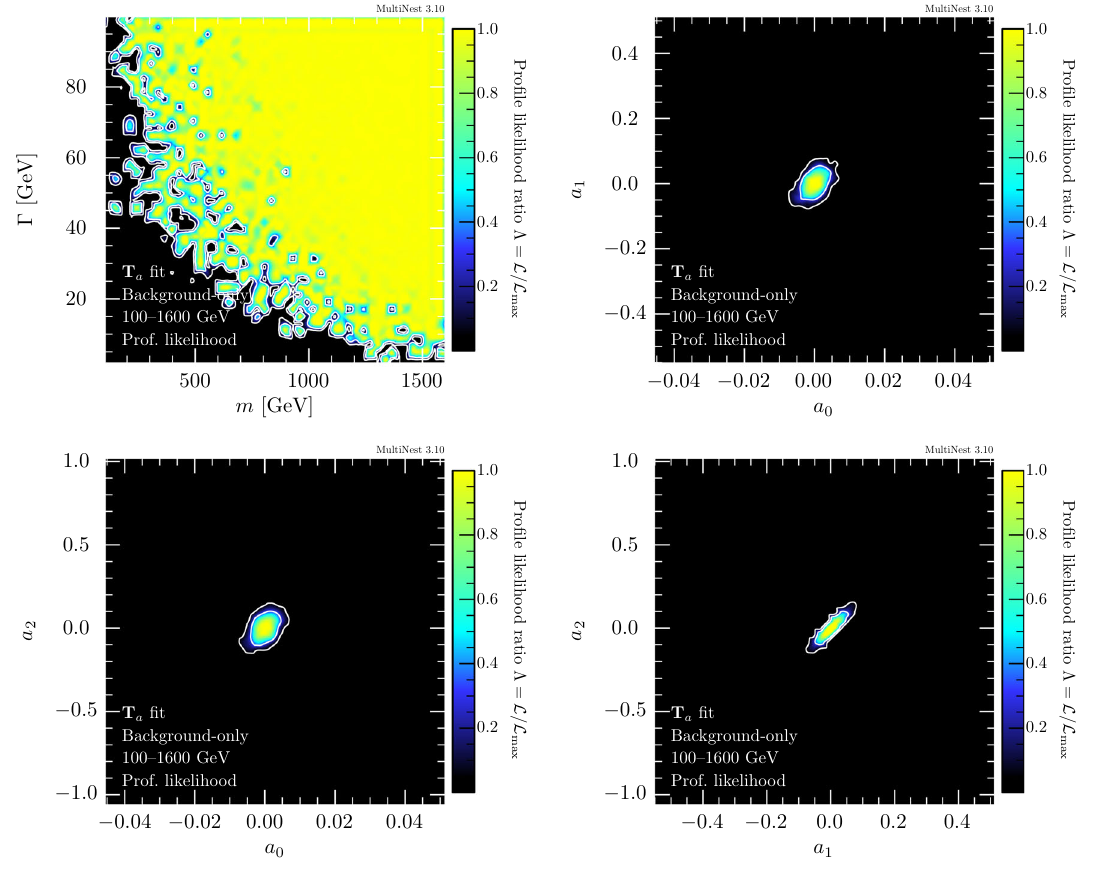
Fig. 9 Fit of the T a parameters to a background-only Asimov over the 100–1600GeV mass range